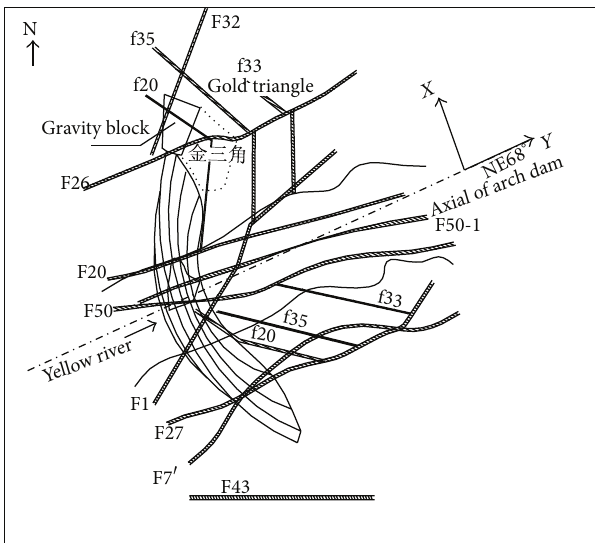
Figure 3: Faults distribution in dam zone of Lijiaxia arch dam [38].